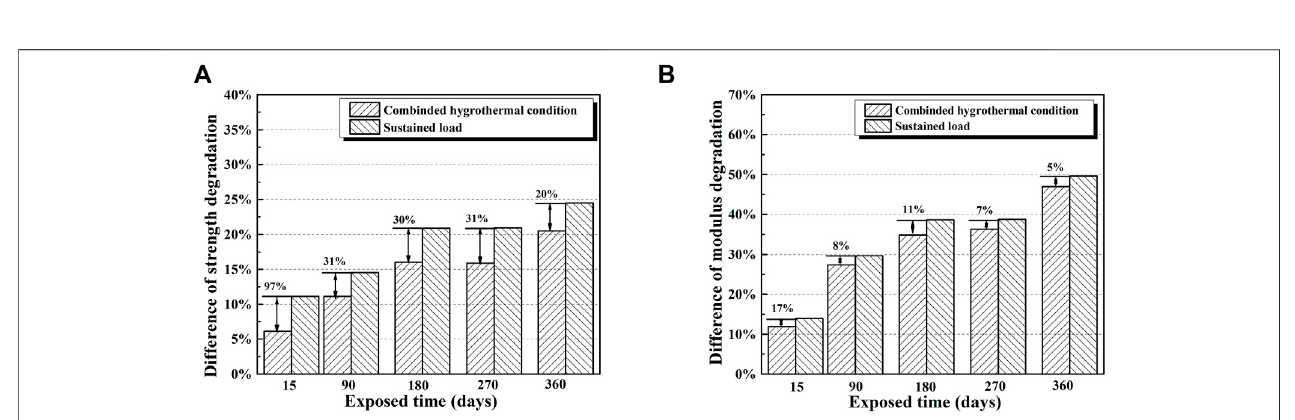
FIGURE 7 | Comparison of the degradation of the tensile properties of UP GFRP: (A) tensile strength and (B) elastic modulus.